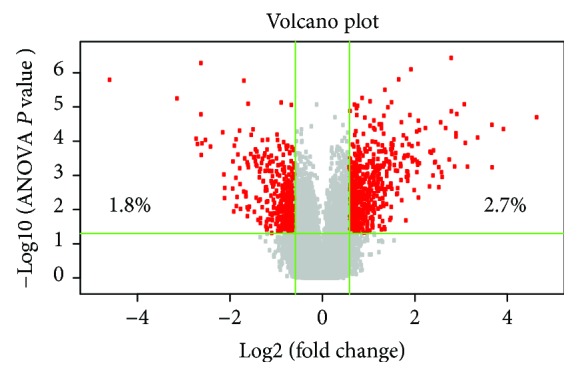
Volcano plot showed differentially expressed genes between the young and old groups. Volcano plot of differentially expressed genes in young and old group. Left: significantly downregulated genes, which account for 1.8% of total detected probes. Middle: nondifferentially expressed genes. Right: significantly upregulated genes, which account for 2.7% of total detected probes (based on ∣log2 FC∣ > 2 and P < 0.05). Heat map and hierarchical clustering of DEG profile comparison between the young and old NPCs are included in the supplementary materials.